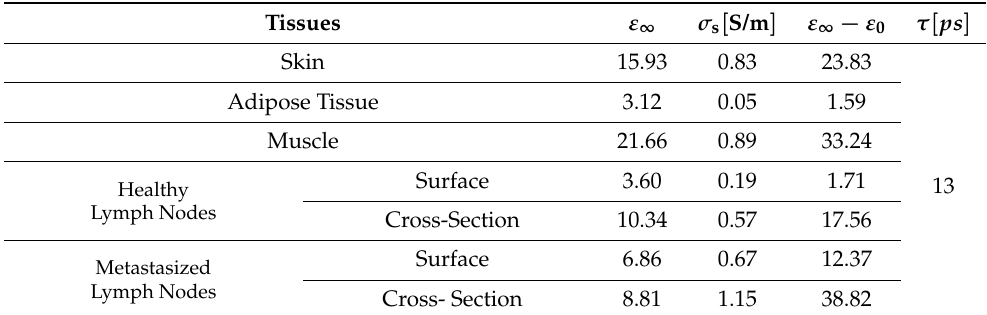
Table 1. Dielectric properties for the tissues in the axillary region used in the Debye formula- tion [2,30,35,36].